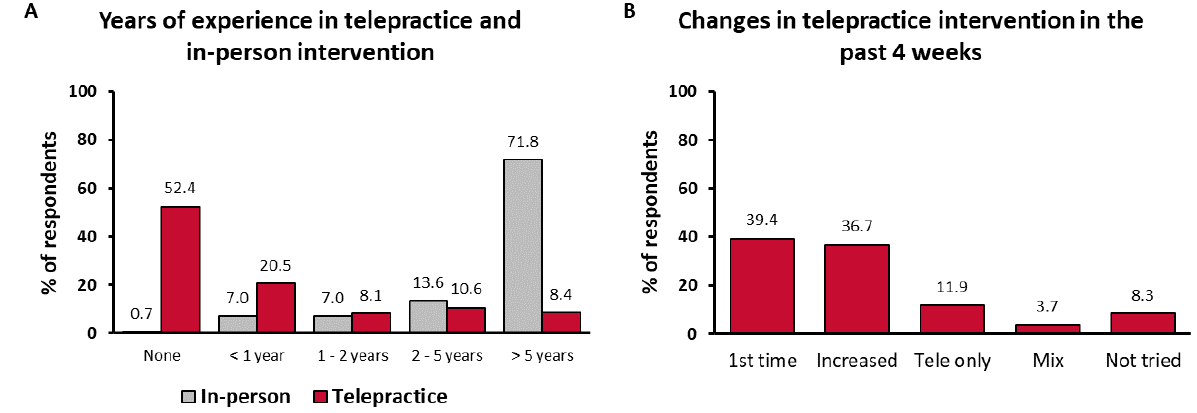
Note. Figure 1.A: Years of Experience in Telepractice (Red) and In-person Intervention (Gray), n = 273;